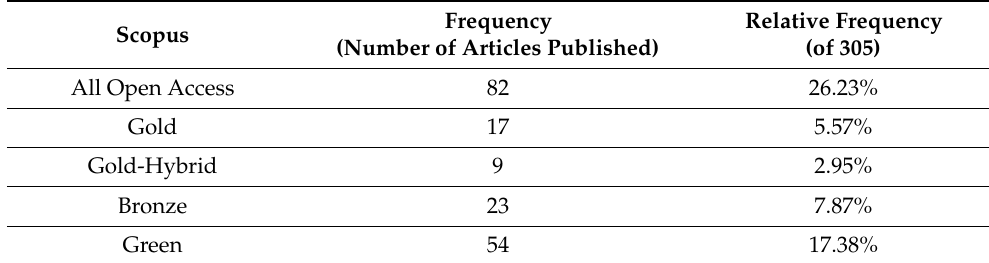
Table 5. Classification of open access articles in